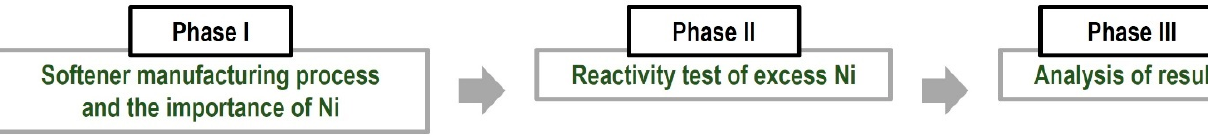
Figure 1. Methodology process.